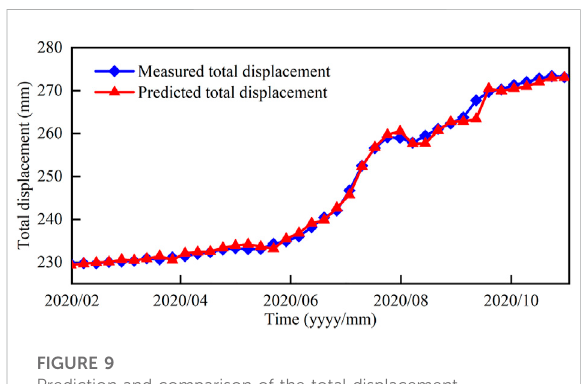
FIGURE 9 Prediction and comparison of the total displacement.